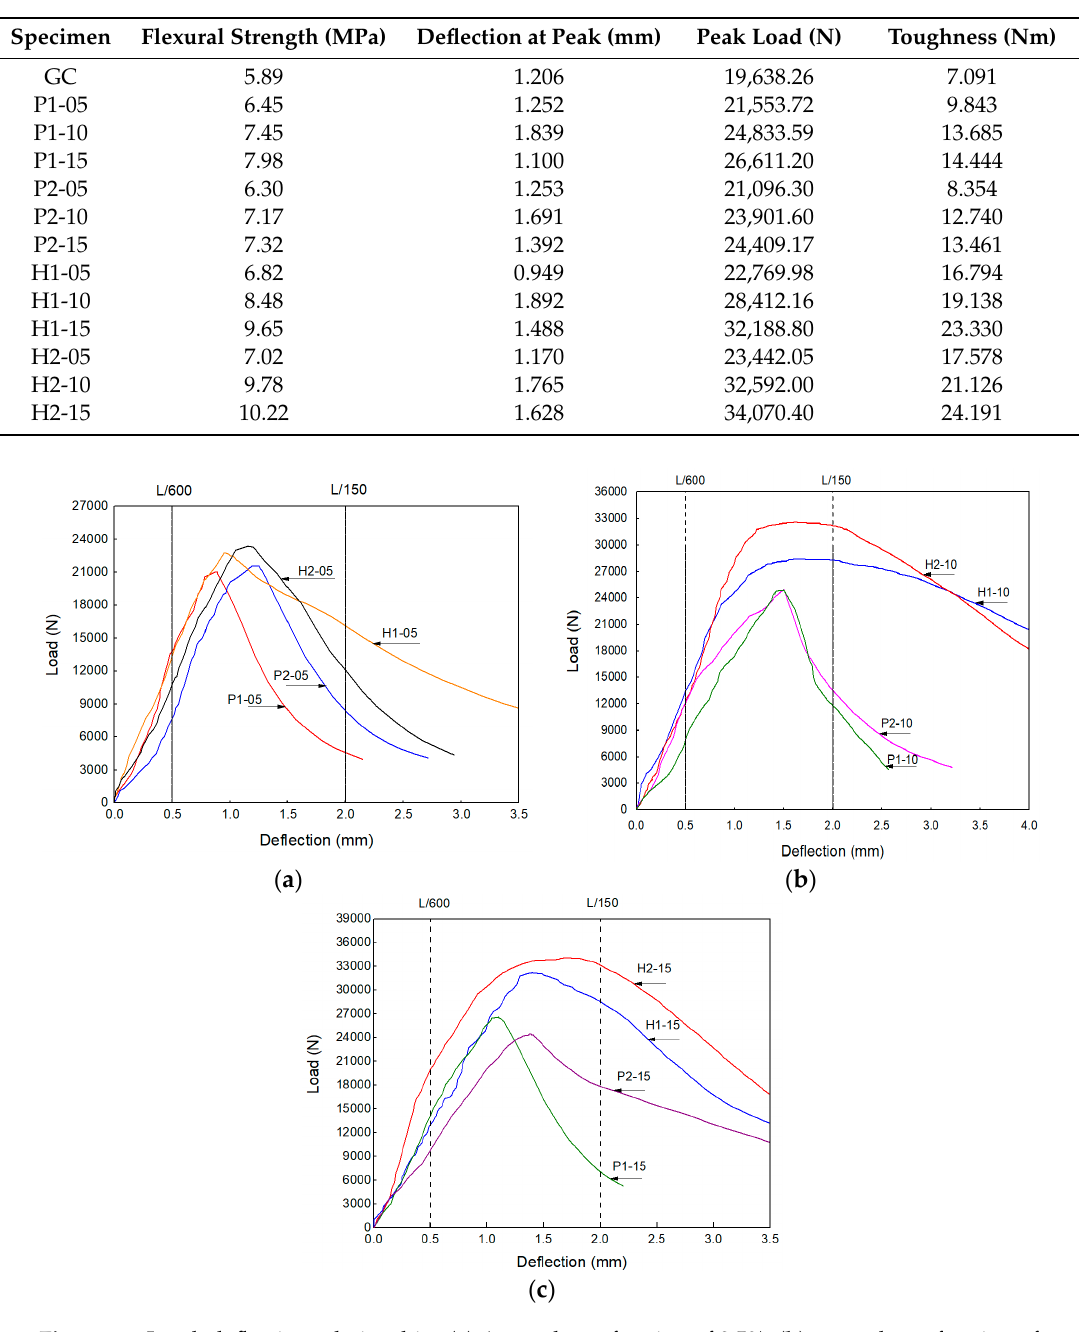
Figure 19. Load–deflection relationship. ( a ) At a volume fraction of 0.5%; ( b ) at a volume fraction of 1.0%; ( c ) at a volume fraction of